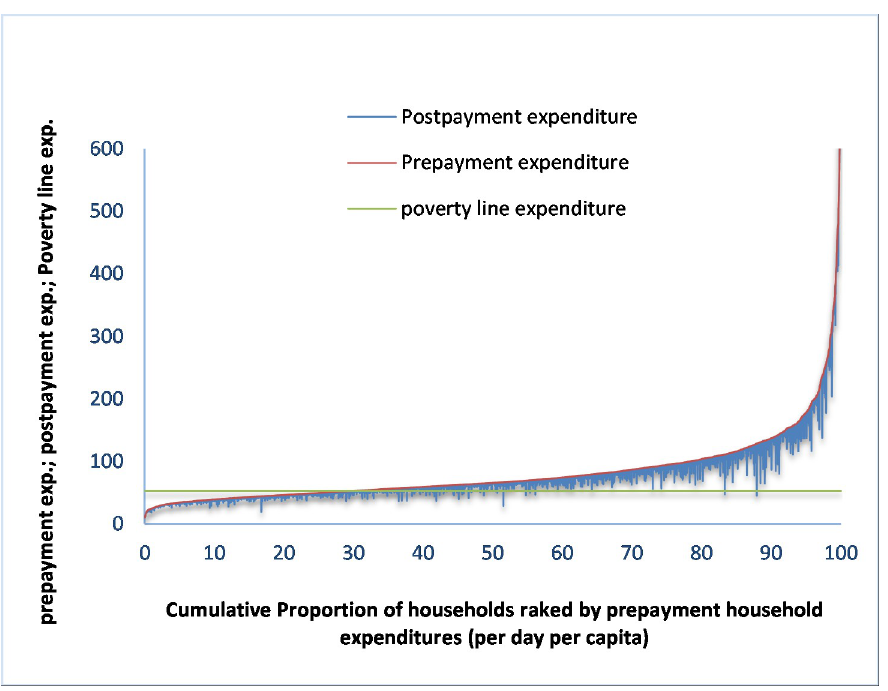
Fig 1. Poverty Pen’s parade graph for all ailments.